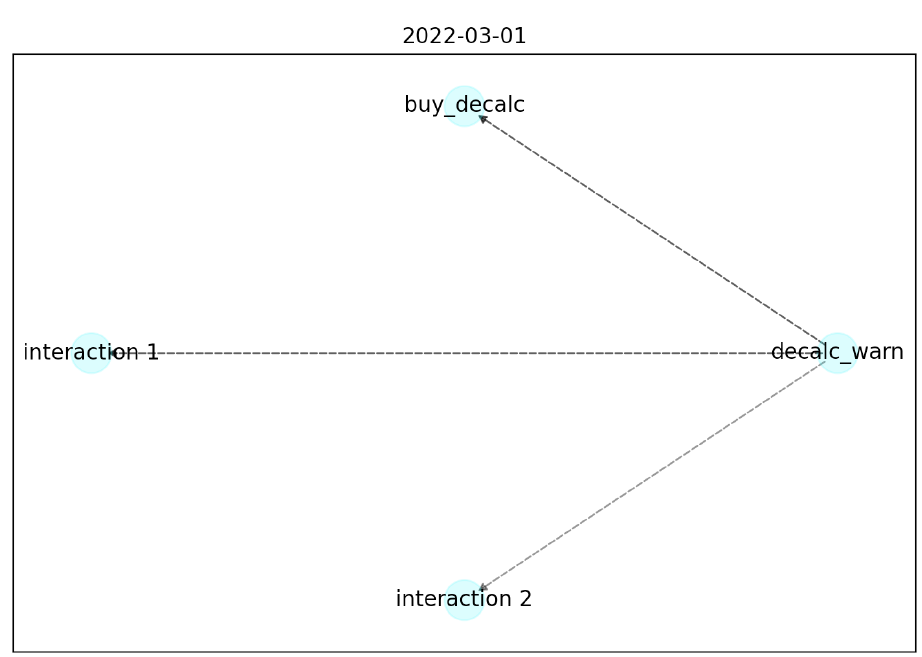
Figure 6. Example: Behavior graph after 2 months. After 4 months from the first day, the graph (Figure 7) change and the edges become greater than the min _ rule _ perc (0.8 for this example). The algorithm creates a graph with all the nodes with an edge greater than the min _ rule _ perc value, divides the graph in